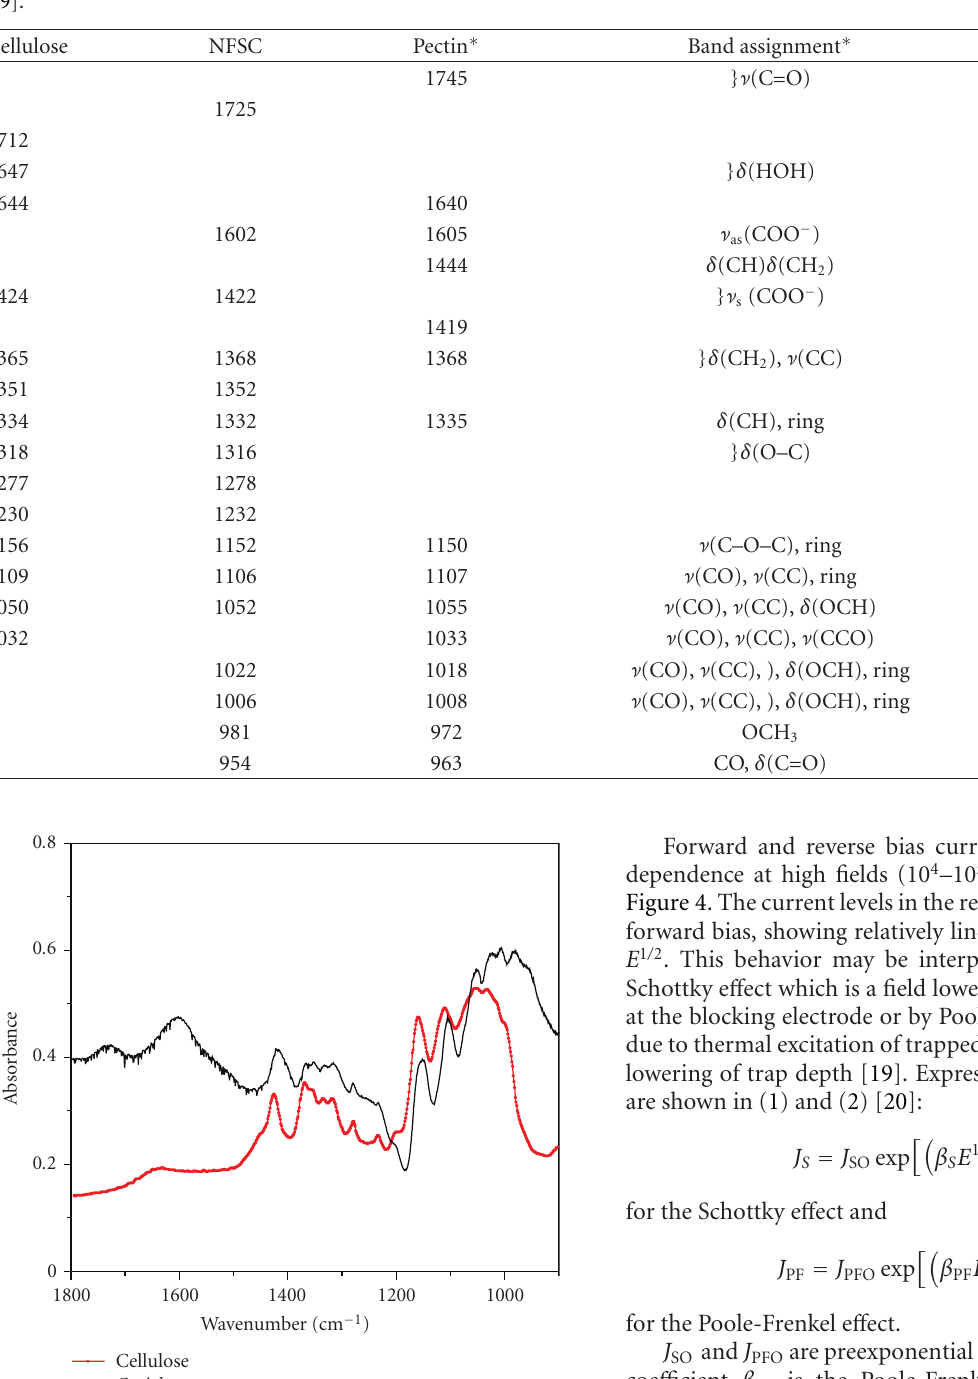
Table 1: FT-IR frenquencies (cm − 1 ) of cellulose, Nandi flame seed cuticle (NFSC), and pectin (PGA-polygalacturonic acid) ∗ Wilson et al. [29].